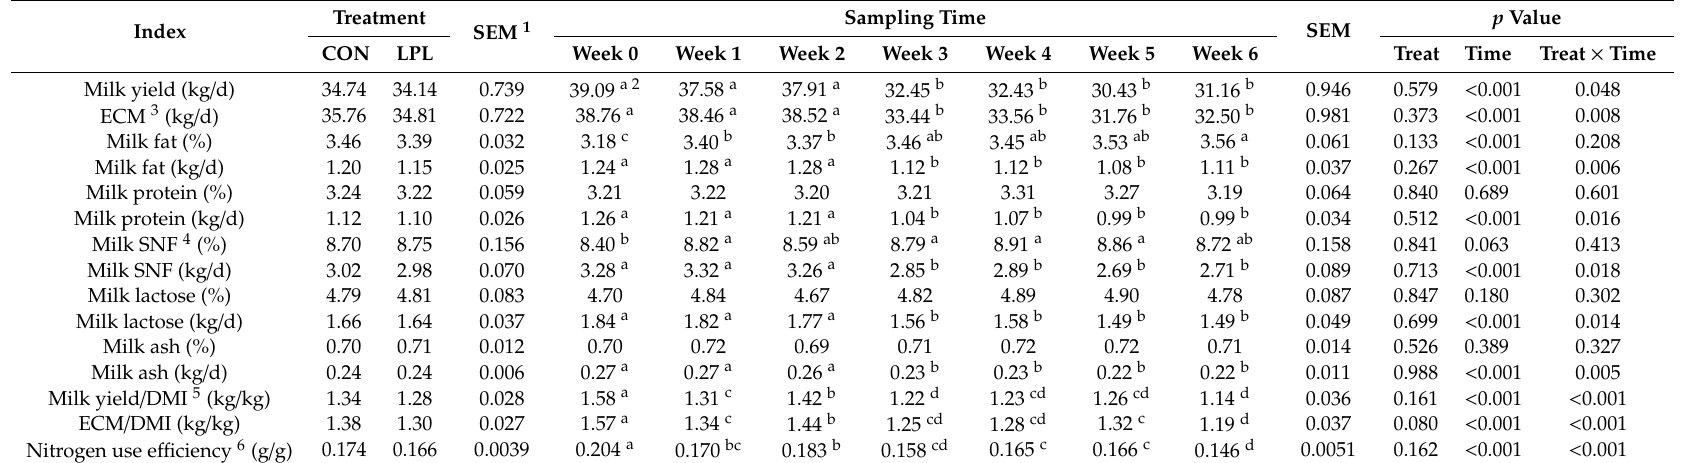
Table 2. Milk yield and compositions, feed conversion e ffi ciency and nitrogen use e ffi ciency of dairy cows fed experimental diets supplemented without (CON) or with (LPL)